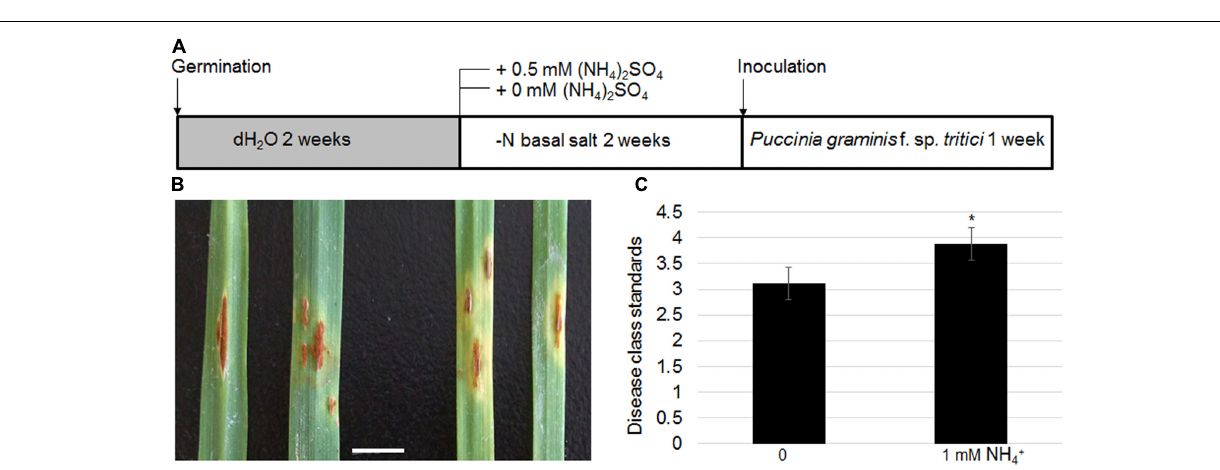
the expression of TaAMT1;1a , TaAMT1;1b , and The gene expression levels of AMTs are sensitive to NH + in 4 Arabidopsis and rice (Sonoda et al., 2003; Loqué et al., 2006). We discovered that TaAMT1;1a , TaAMT1;1b , and TaAMT1;3a were not altered by NH + treatment ( Figure 5C ). In addition, 4